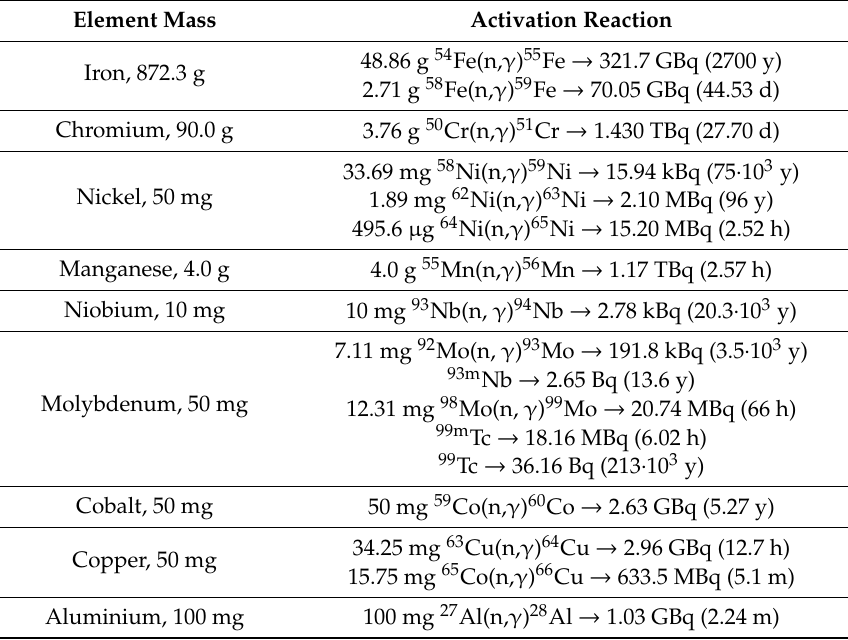
Table 4. Activation of 1 kg of EUROFER with slow and thermal neutrons, after turning o ff the